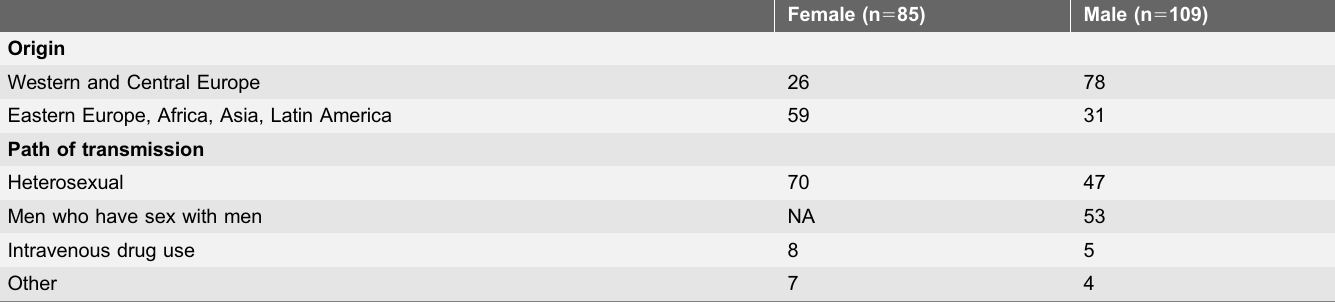
Table 1. Demographic data of the participants (n 5 194); path of transmission and origin, by